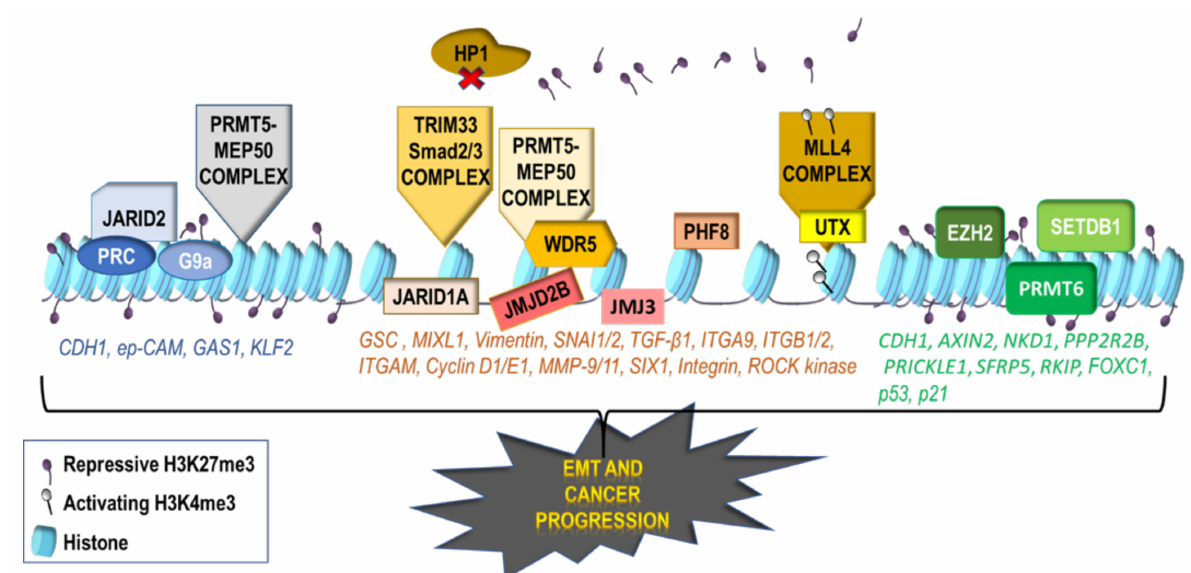
Figure 3. Role of histone methylation in gene regulation during tumor progression. Trimethylation of H3K27 and H3K4 has been associated with suppression of epithelial genes or activation of mesenchymal ones, respectively. In this process, the PRMT5-MEP50 complex suppresses CDH1 and GAS1 by mediating H3K4 and H4R3 methylation. E-cadherin is suppressed by SNAI1-mediated PRC2 trimethylation of H3K27. PRC2 also suppresses KLF2 expression. JARID2 recruits both PRC2 and G9a to promote H3K27 and H3K9 methylation at the promoters of CDH1 and miR-200 . G9a also silences the ep-CAM gene, promoting metastasis. The TRIM33/Smad2/3 complex inhibits the binding of HP1 on the DNA, leading to expression of GSC and MIXL1 mesenchymal genes. The PRMT5-MEP50 complex recruits WDR5 and causes H3R2 methylation, activating the EMT-promoting genes VIM and SNAI1/2 . Over-expression of the histone demethylase, JARID1A leads to the activation of cyclin D1/E1 and ITGB1 expression, promoting tumor progression. The H3K27 demethylase, UTX, activates several pro-metastatic genes, such as MMP-9/11 and SIX1 , after interacting with the MLL4 complex, which includes a H3K4 methyltransferase, thus causing enhancement of EMT and metastasis. The PHF8 demethylase upregulates the expression of Vimentin, Integrin, and Rho-associated protein kinase (ROCK) kinase by removing H3K9 methylation marks, thus favoring metastasis. JMJD2B, a H3K9 demethylase, induces the expression of Vimentin, after interacting with β -catenin and also demethylates the Integrin (ITGB2, ITGAM, ITGA9, ITGAB2) gene promoters, further promoting EMT and metastasis. JMJ3, a H3K27 histone demethylase is induced by TGF- β and activates SNAI1 expression to facilitate EMT. EZH2 establishes repressive H3K27me3 marks and downregulates FOXC, inducing metastasis. It also silences the CDH1, AXIN2, NKD1 , PPP2R2B , PRICKLE1 , SFRP5 , RKIP , promoting EMT and cancer metastasis. SETDB1 methyltransferase amplification is responsible for cancer cell growth by methylating and stabilizing the oncogenic p53 mutants. In this context, PRMT6 methyltransferase reduces the expression of p21, promoting tumor cell